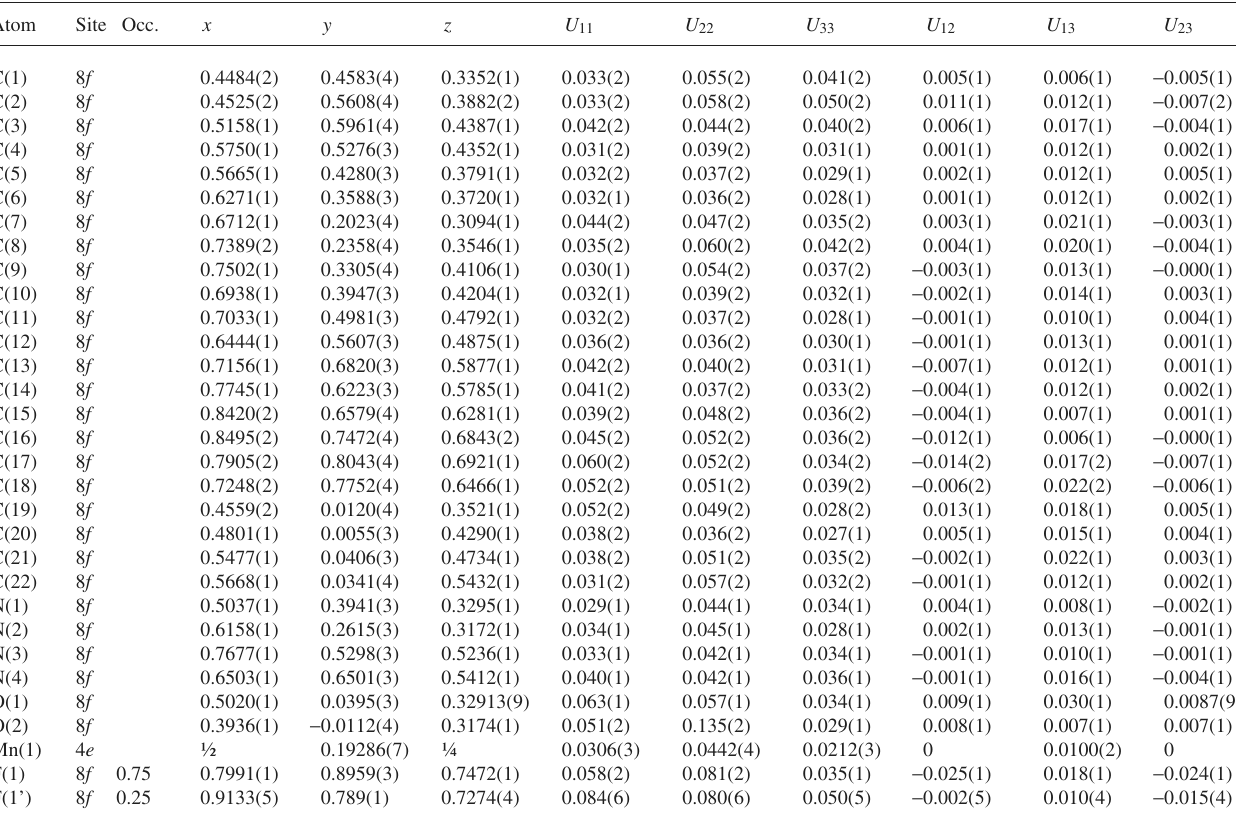
Table 3. Atomic coordinates and displacement parameters (in Å 2 ) . Atom Site